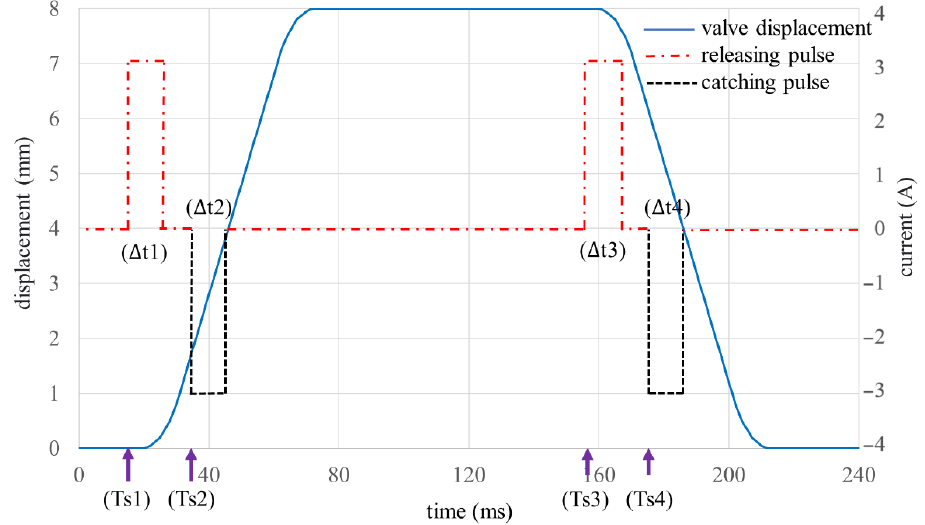
Figure 6. Improved EM valve operation cycle and release current actuation timing.